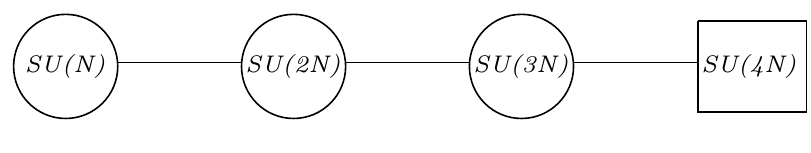
Figure 1. The quiver encoding the dynamics of our (cid:12)rst example